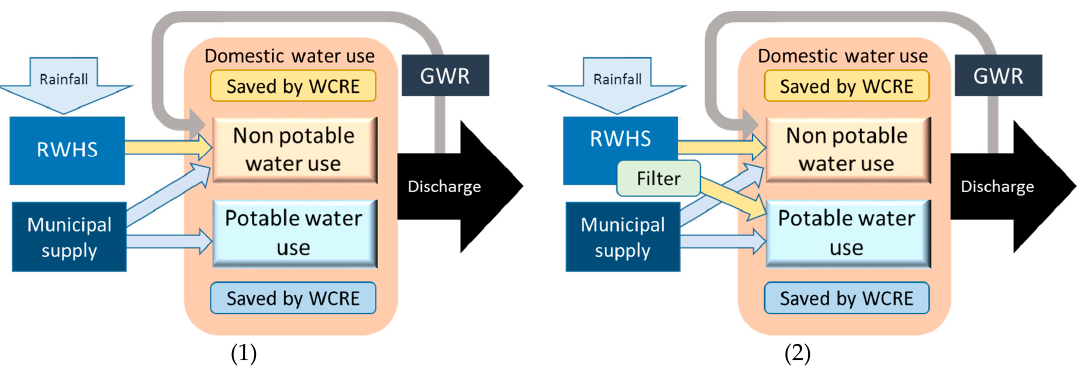
Figure 3. ( 1 ) RHWS of Scenario A, integrated with WCRE and GWR; ( 2 ) RHWS of Scenario B with filter integrated with WCRE and GWR.